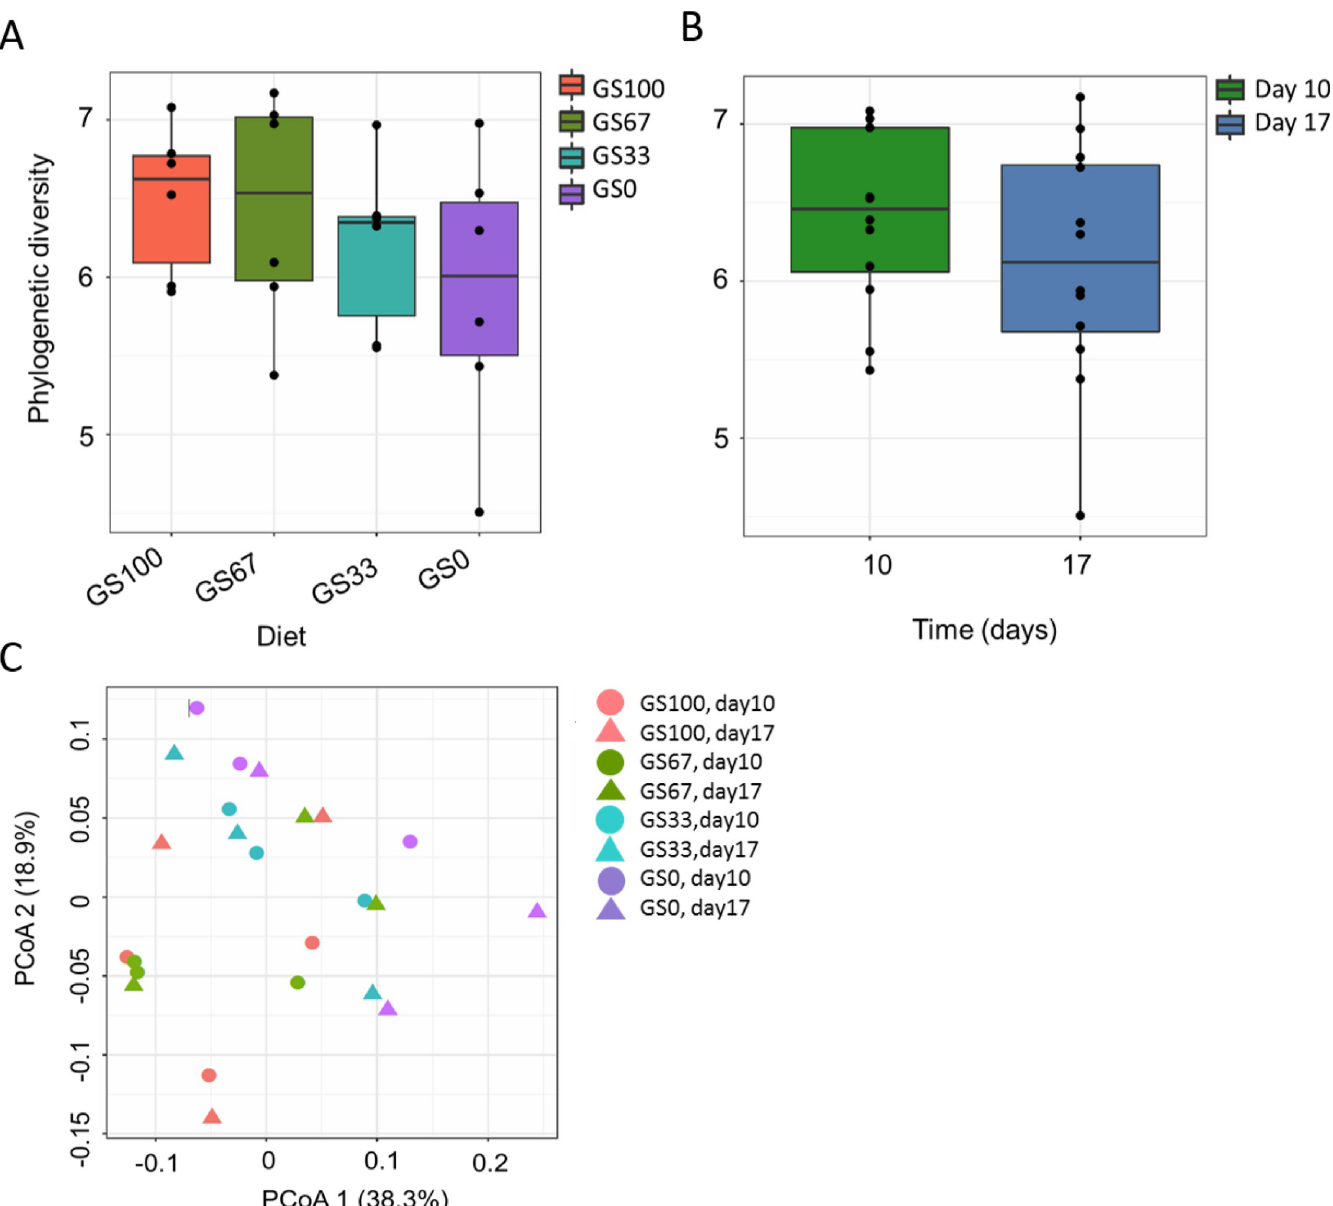
Fig 5. Alpha and beta diversity analysis of rumen archaeal communities. Phylogenetic diversity (PD) of archaeal communities associated to (A) different ratios of grass and maize silage and (B) different time points. Sample codes indicate the number of days that the diet had been fed (10 or 17) and the different grass and maize silage proportions in the diet, for example GS100 is 100% grass silage. Principal co-ordinate analysis ( PCoA) analysis of archaeal community composition from rumen fluid samples (n = 24) using (C) the unweighted UniFrac distance metric. The percentage of variation explained is indicated on the respective